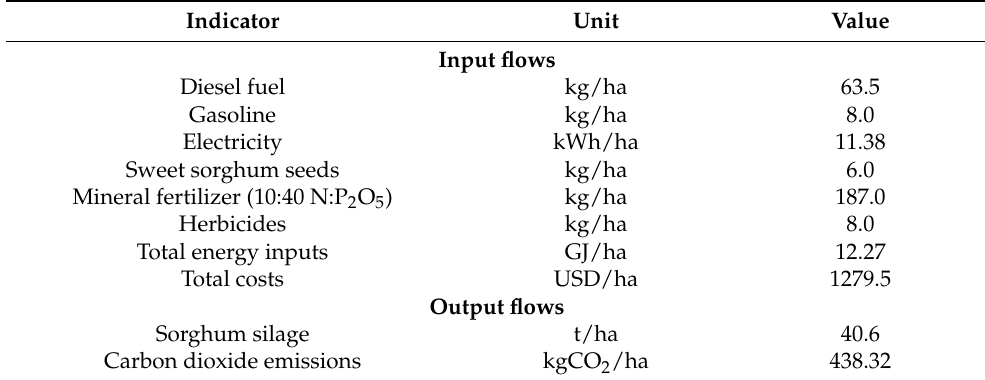
Table 1. Input and output